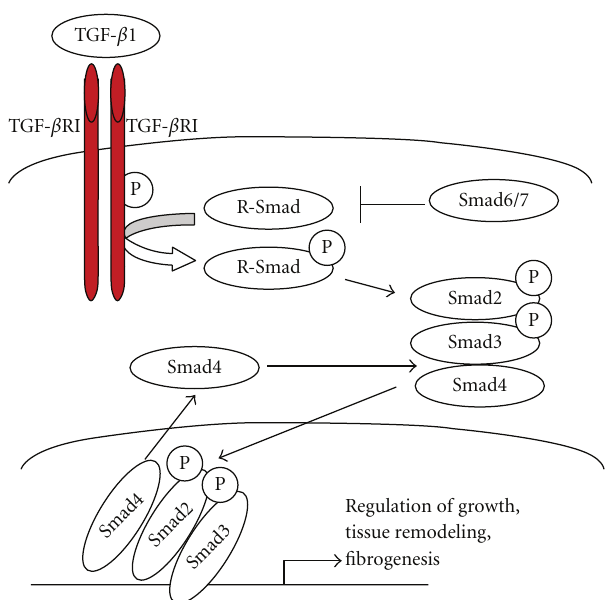
Figure 1: TGF- β 1 signaling. At the cell surface, TGF- β 1 binds a complex of transmembrane receptor serine/threonine kinases types I and II (TGF- β RI and TGF- β RII) and induces transphosphory- lation of the the type I receptor by the type II receptor kinases. The activated type I receptor phosphorylates Smad2 and Smad3, which then form a complex with a common Smad4. Activated Smad complexes translocate to the nucleus and function as transcription factors. Activation of R-Smads by type I receptor kinases is inhibited by Smad6 or Smad7. R-Smads and Smad4 shuttle between nucleus and